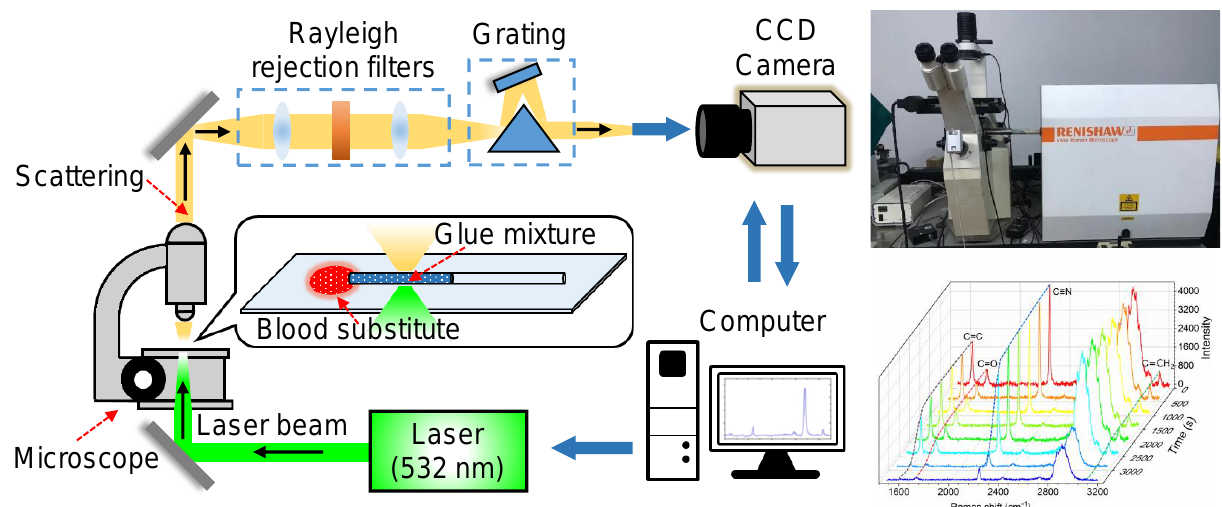
Figure 2. Schematic of experiment setup for characterizing the polymerization kinetics of glue–oil mixtures induced by blood